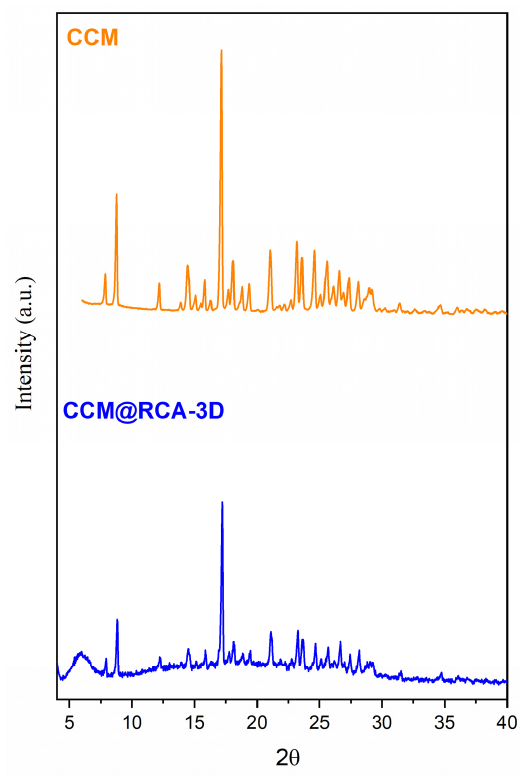
Figure 11. X-ray powder diffraction pattern of free CCM and CCM@RCA-3D sample.